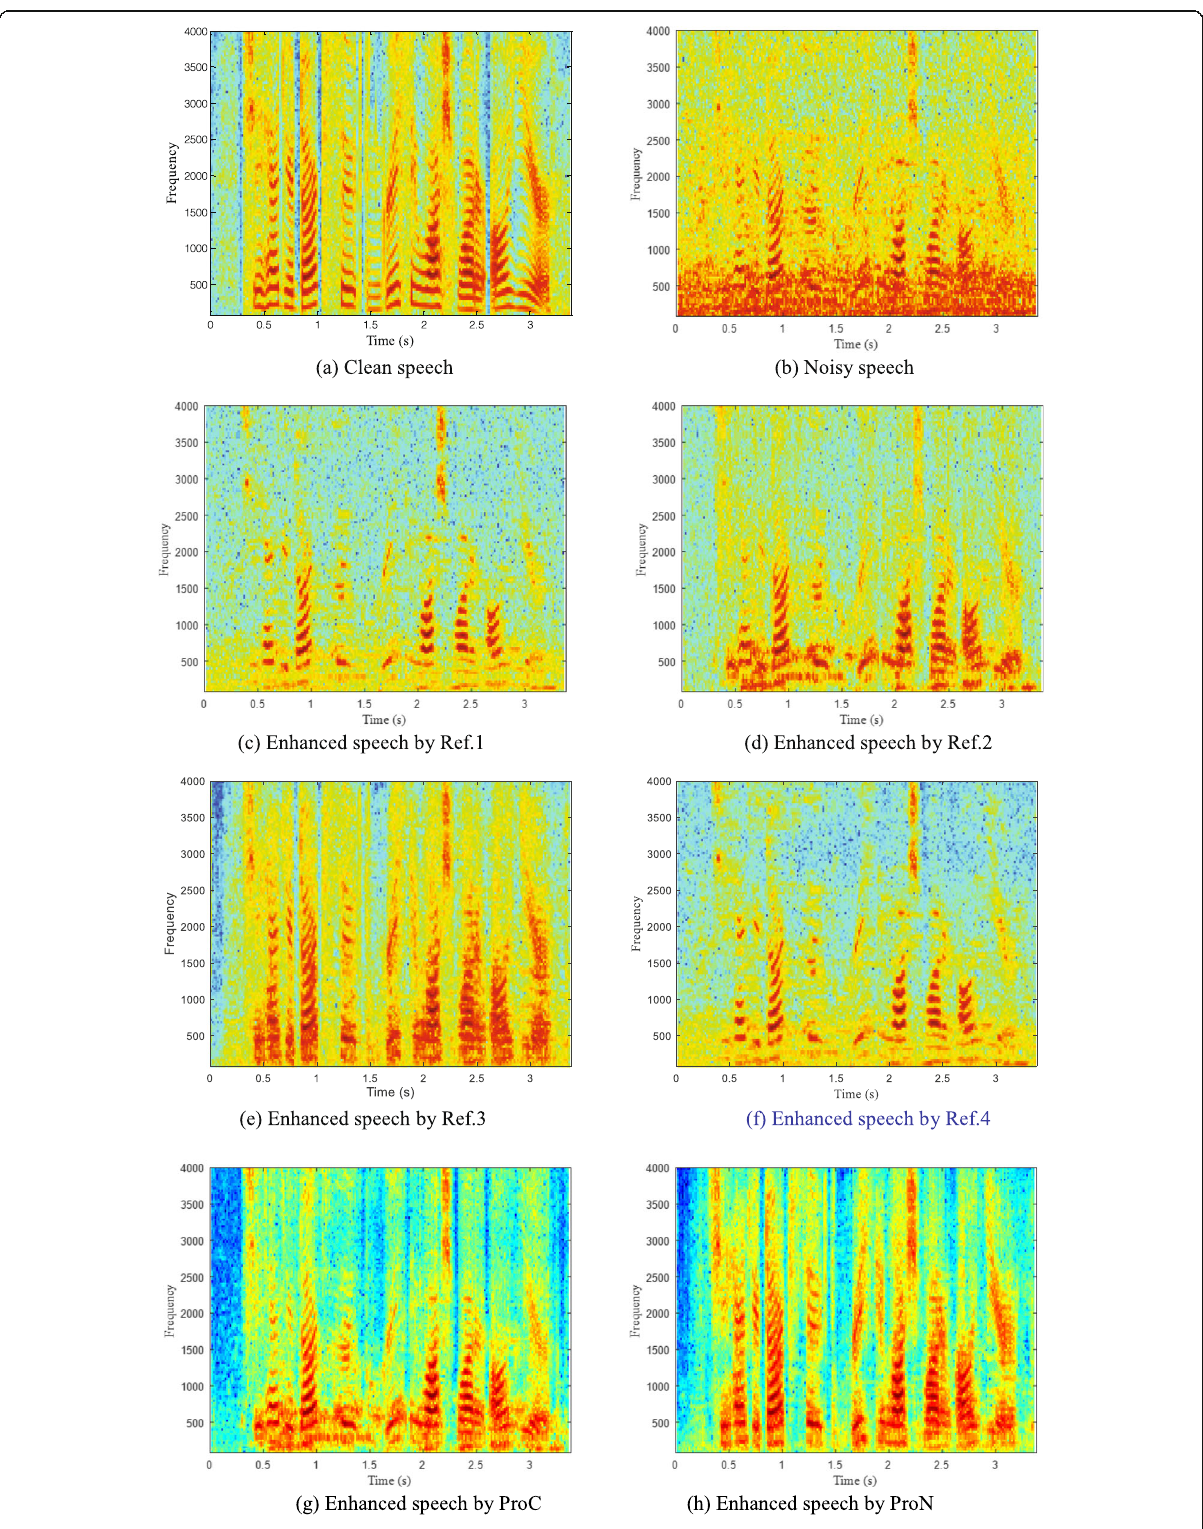
Fig. 8 Spectrogram comparison of different methods. a Clean speech. b Noisy speech. c Enhanced speech by Ref.1. d Enhanced speech by Ref.2. e Enhanced speech by Ref.3. f Enhanced speech by Ref.4. g Enhanced speech by ProC. h Enhanced speech by